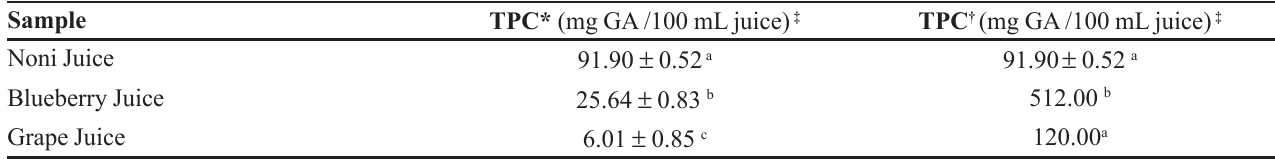
TABLE I - Means and standard deviation of Total Polyphenol Content of Noni, Blueberry and Grape Juices